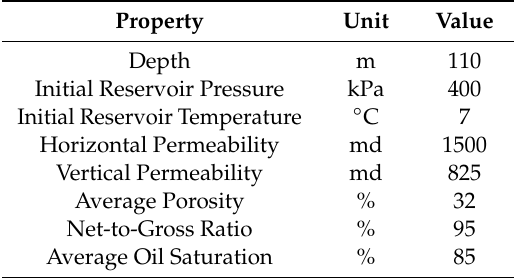
Table 3. Steam assisted gravity drainage (SAGD) 3D model reservoir